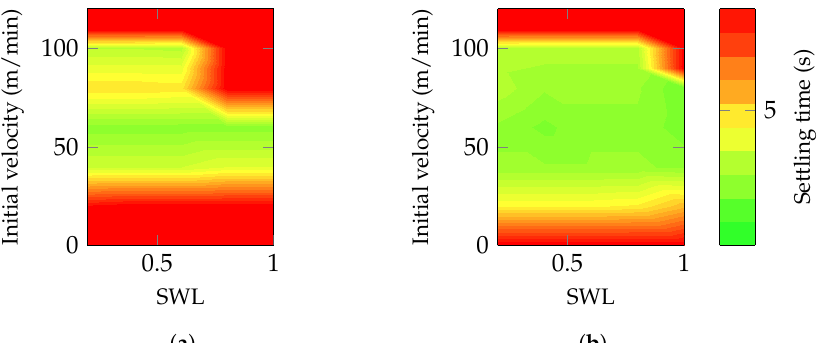
Figure 10. Settling time within 2% after a 5 m/min step increase of the reference velocity: ( a ) Classic; ( b ) SSC.